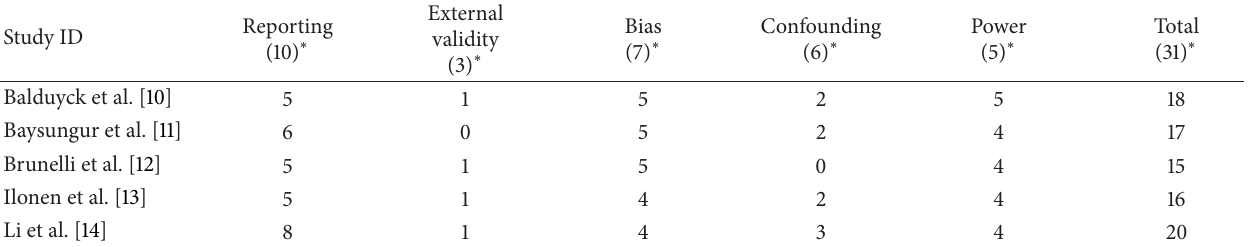
Table 1: Results of the risk of bias assessment using the Downs and Black assessment tool.